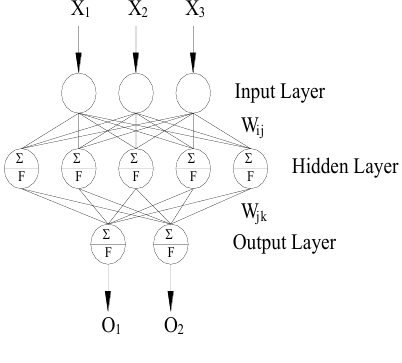
Fig. (1) Structure of Artificial Neural